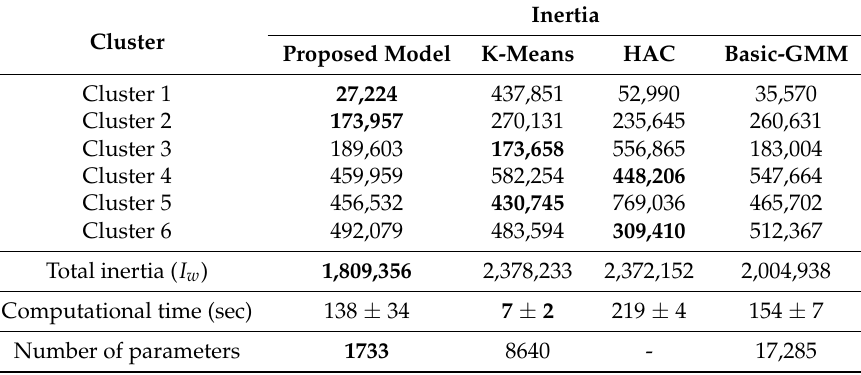
Table 2. Comparison between the proposed model, K-means, Hierarchical Ascendant Classification and Basic Gaussian Mixture Model according to intra-class inertia, computational time and number of